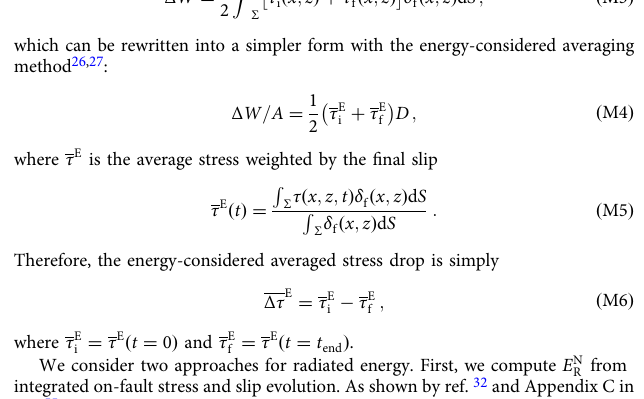
Fig. 4 Source time function _ M ð t Þ of numerical simulations and natural earthquakes. a All models follow an identical _ M ð t Þ / t 2 growth independent of scaling parameter χ until reaching unfavorable stress conditions. The black dotted curve is a quadratic fi t for growth phase of moment rate history. b Normalized source time functions, where T C ¼ in ref. 48 . c Scaled source time functions with matching growth phase. Green and red curves are natural earthquakes at various source depths H adapted from ref. 47 . d Source time function of a rupture nucleated at the center of the stress plateau, and at the edge of the stress